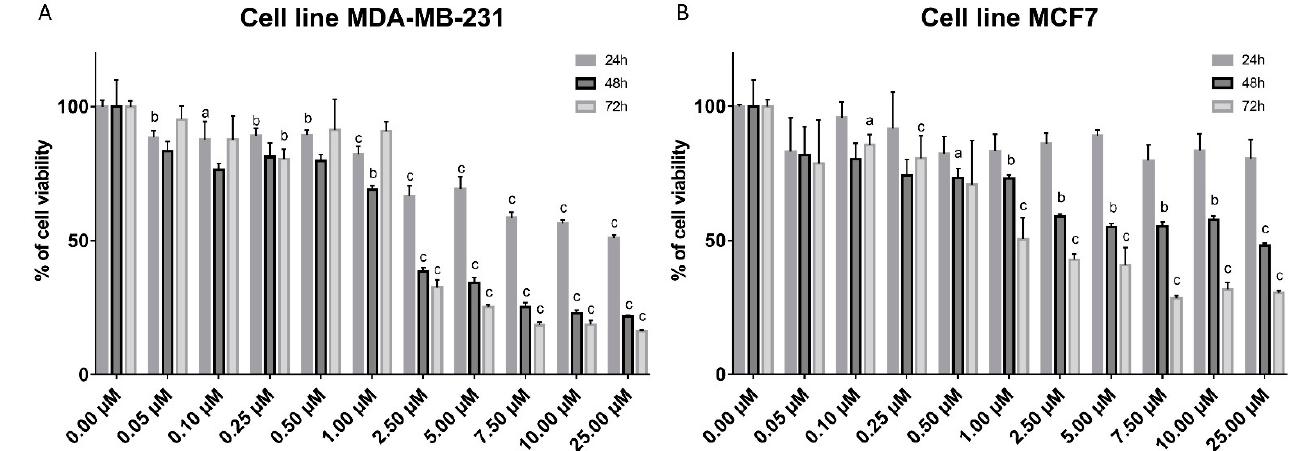
Figure 1. Cell viability after compound 1 treatment. Notes: Cells were treated with a different concentration of compound 1 for 24, 48 and 72 h in the MDA-MB-231 ( A ) and in the MCF-7 cell line ( B ), and cell metabolism was evaluated by the 3-(4,5-dimethylthiazolyl-2)-2,5-diphenyltetrazolium bromide (MTT) assay. Data are expressed as a mean from the experiment performed in triplicate ± SD. Columns, mean of viable cells; bars, SD (standard deviation); a, p < 0.05; b, p < 0.01; c, p < 0.001. SD, standard deviation.